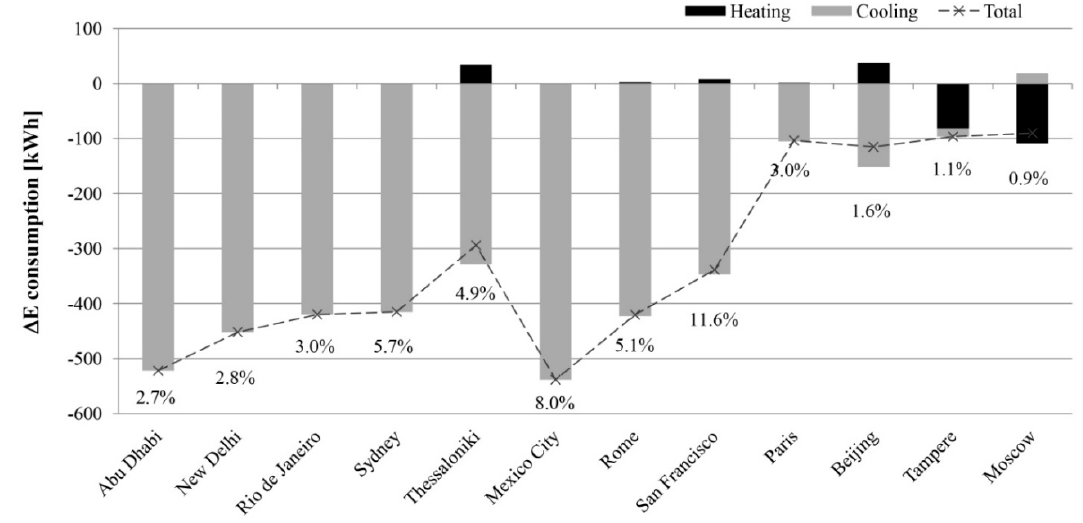
Figure 7. Di ff erence of building HVAC energy consumption between the optimum and the “standard roof” configuration in each climate zone, reporting the annual and the separate contributions for heating and